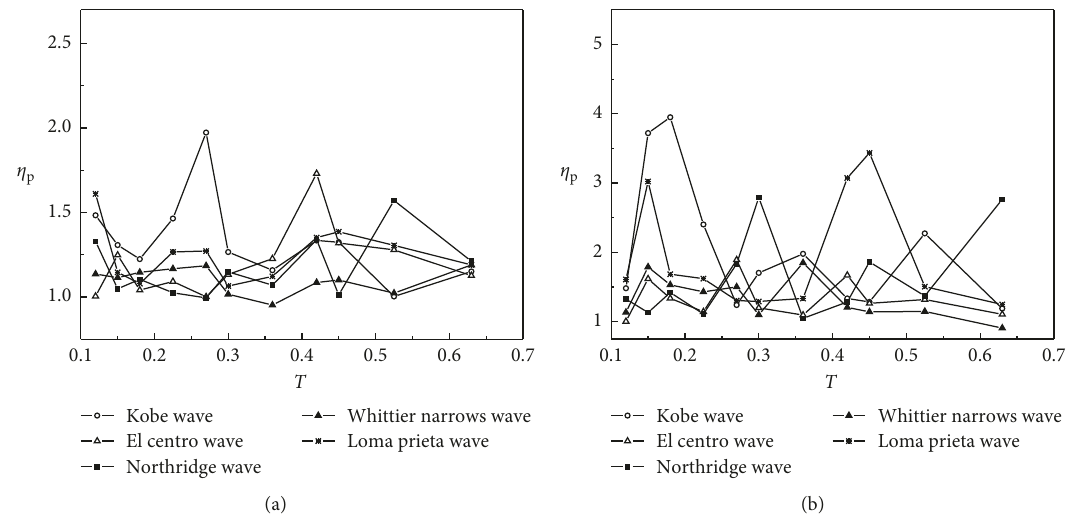
Figure 14: Influence of structural period T : (a) ξ